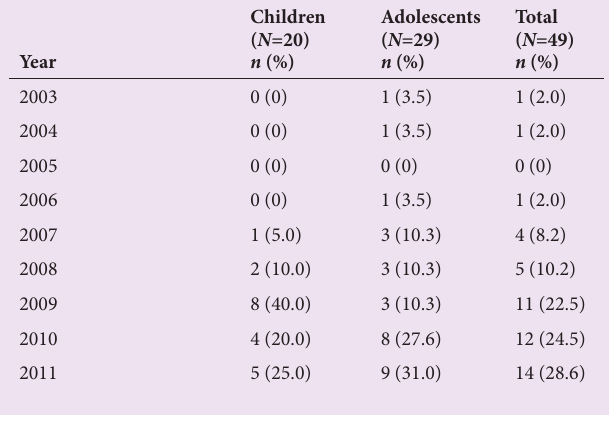
Table 2. Number of participants evaluated for PTSD per year, 2003 - 2011